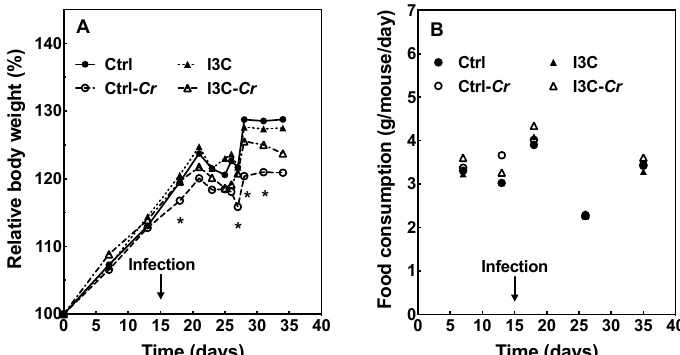
Figure 2. I3C ameliorates the loss of body weight caused by Citrobacter rodentium (Cr) infection but has no e ff ect on food consumption in mice. ( A ) Body weight, the body weight of mice on di ff erent days was normalized to each animal’s body weight on day 0. ( B ) Food consumption, infection with Cr was initiated on day 15 after start of the diet. Results were expressed as mean or mean +/ − SD (n = 8), * indicates significant di ff erence between the Ctrl-Cr and I3C-Cr groups ( p < 0.05). Only within-day comparisons were made. Ctrl: control diet; Ctrl-Cr: control diet, Cr-infected; I3C: I3C diet; I3C-Cr: I3C diet,